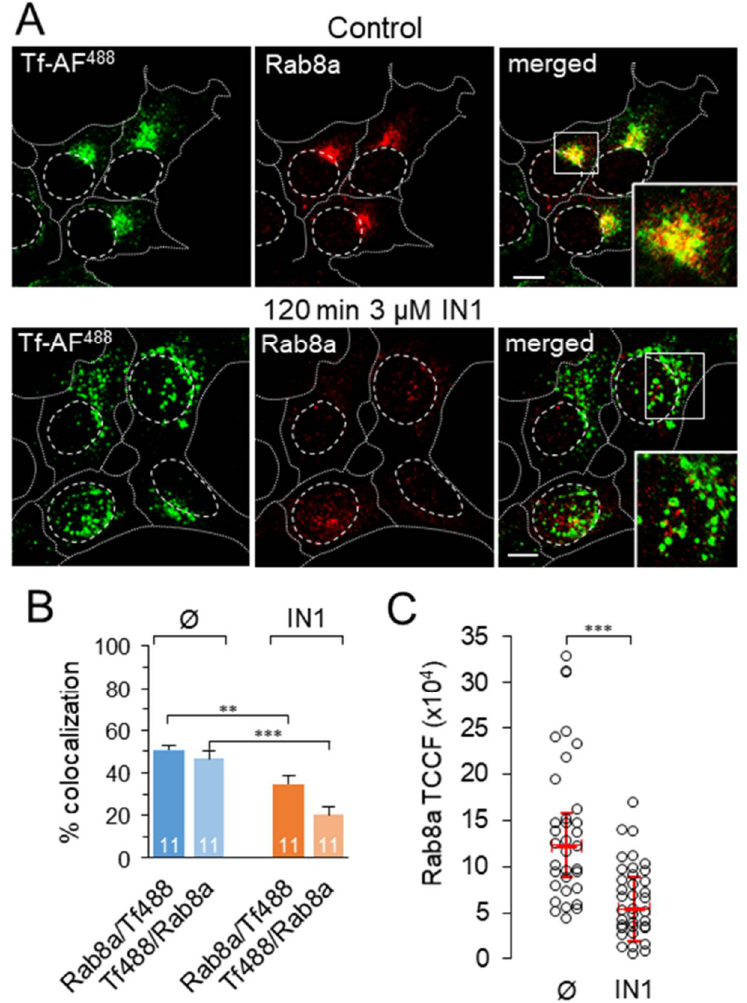
Figure 6. IN1 treatment depletes pericentriolar Rab8a-positive endosomes. ( A ) Representative images ( n = 10–12) of internalized Tf-AF 488 (45 min) and Rab8a in control and 120 min IN1-treated cells. ( B ) The 3D colocalization of TF-AF 488 and Rab8a is based on the M1/M2 coefficients of pixel overlap measured across the Costes-algorithm thresholded z -stacks of confocal images. Data represent means ± SEM (number of cells indicated in bars); *** p < 0.001; ** p < 0.01 (two-tailed t -test). ( C ) Total corrected cell fluorescence (TCCF) of Rab8a in each cell was quantified using ImageJ on Otsu-thresholded confocal images. Data represent individual cells, and horizontal bars represent median value; *** p < 0.001 (two-tailed t -test).